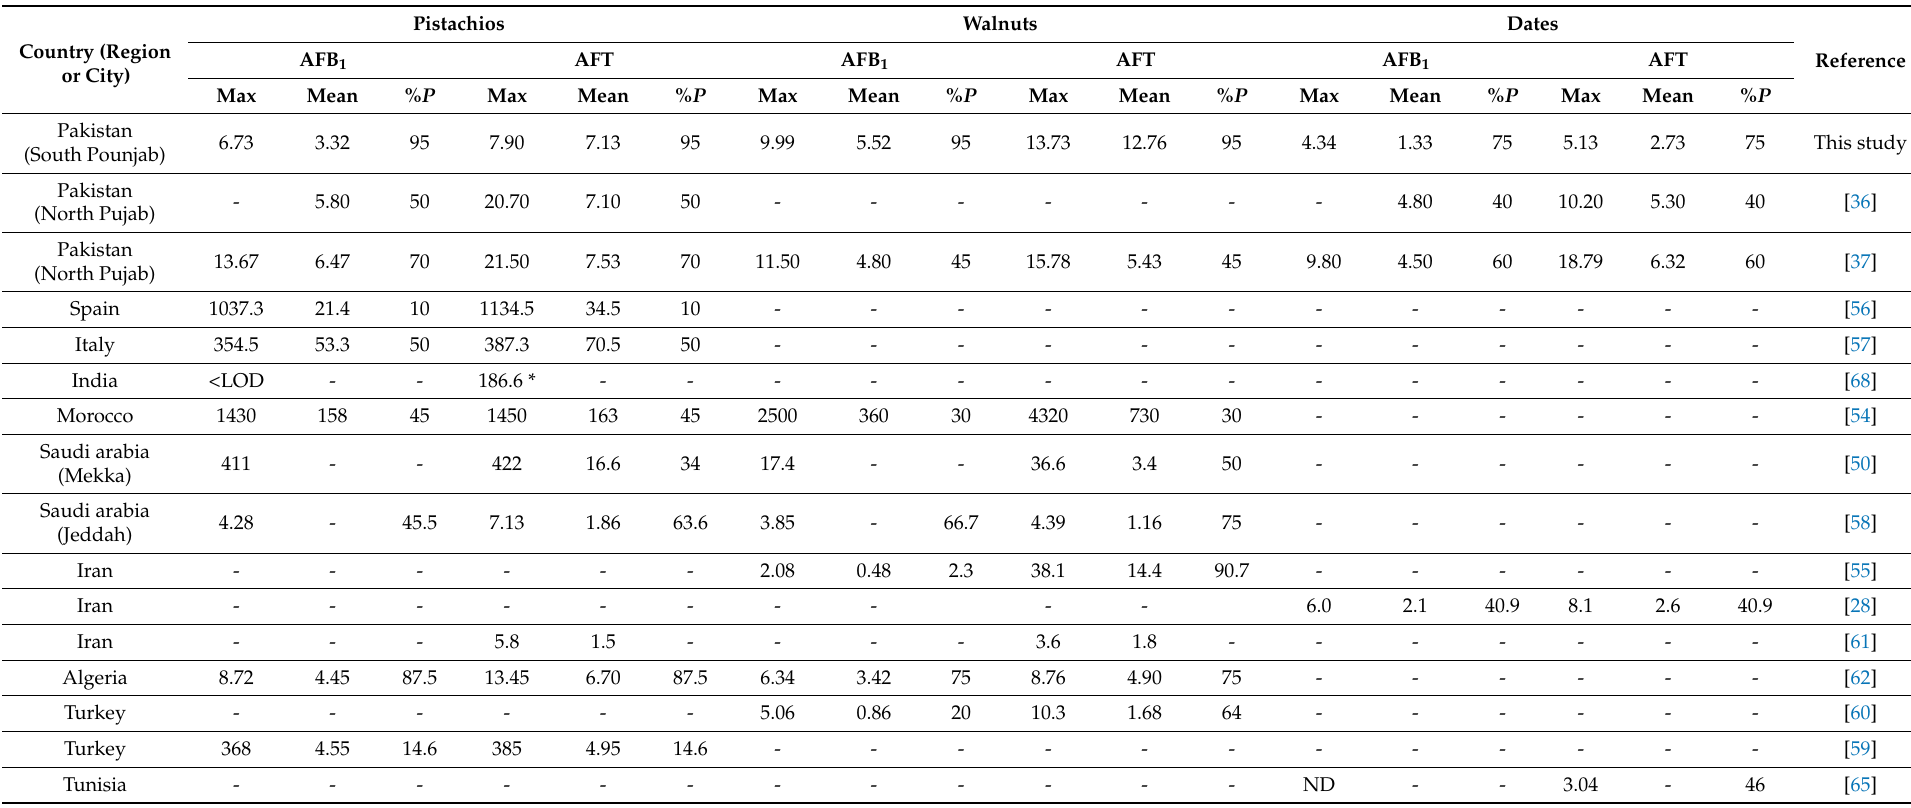
Table 3. Comparison between the contamination levels (ng/g) of pistachios, walnuts, and dates with aflatoxin B1 (AFB 1 ) and total aflatoxins (AFT) obtained in